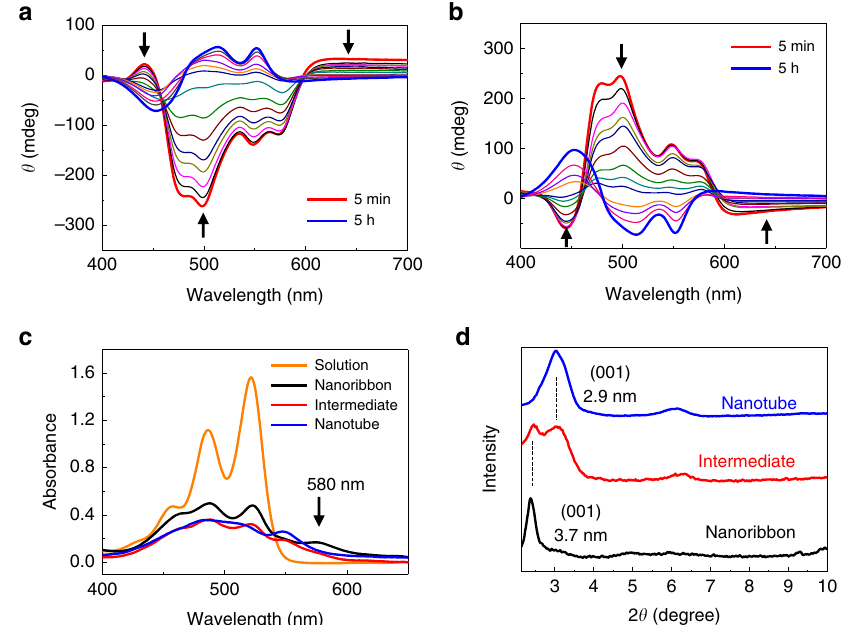
Fig. 3 Spectroscopic monitoring of the self-assembly process. a , b Time-dependent changes in CD spectra of 10% CHCl 3 /EtOH solutions (27 μ M) of 1-R ( a ) and 1-S ( b ) obtained by heating at 65 °C followed by cooling at 15 °C from 0 to 5 h. c Visible absorption spectra of 1-R obtained at 65 °C (orange line, unassembled 1-R ), 5 min (black line), 3 h (red line), and 5 h (blue line) following initiation of self-assembly by cooling a heated solution from 65 to 15 °C. d Powder XRD spectra of 1-R obtained 5 min (black line), 3 h (red line), and 5 h (blue line) following initiation of self-assembly by cooling a heated solution from 65 °C to 15